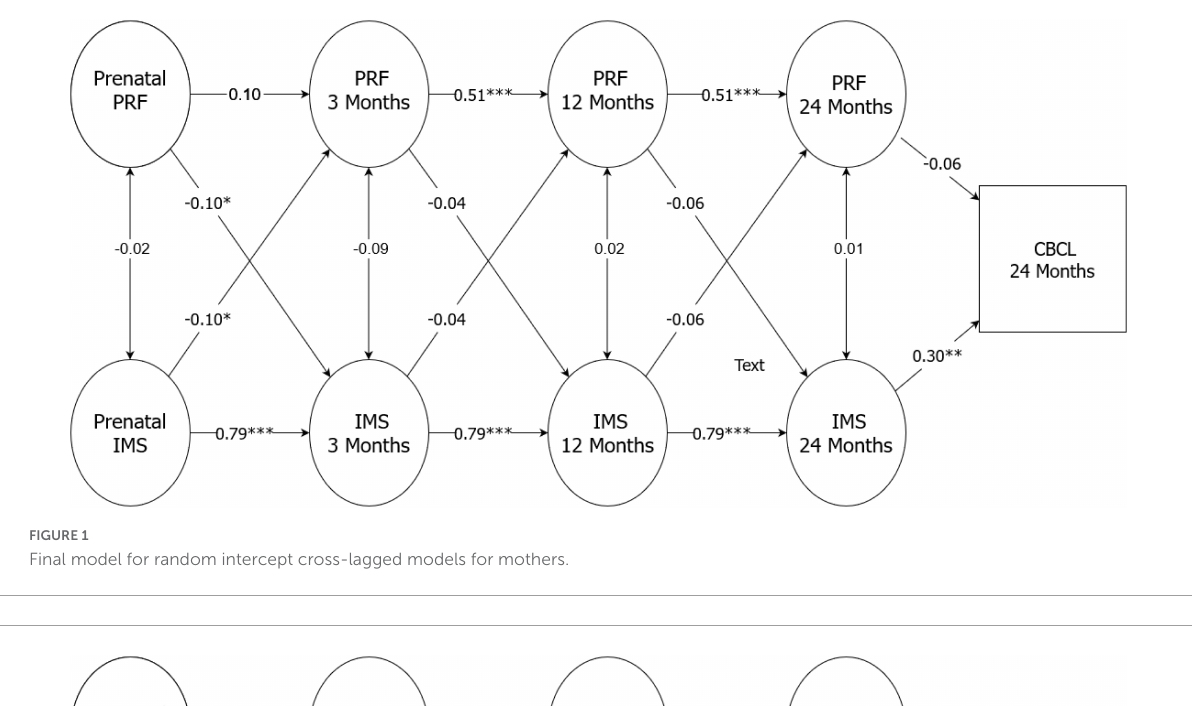
FIGURE1 Final model for random intercept cross-lagged models for mothers.